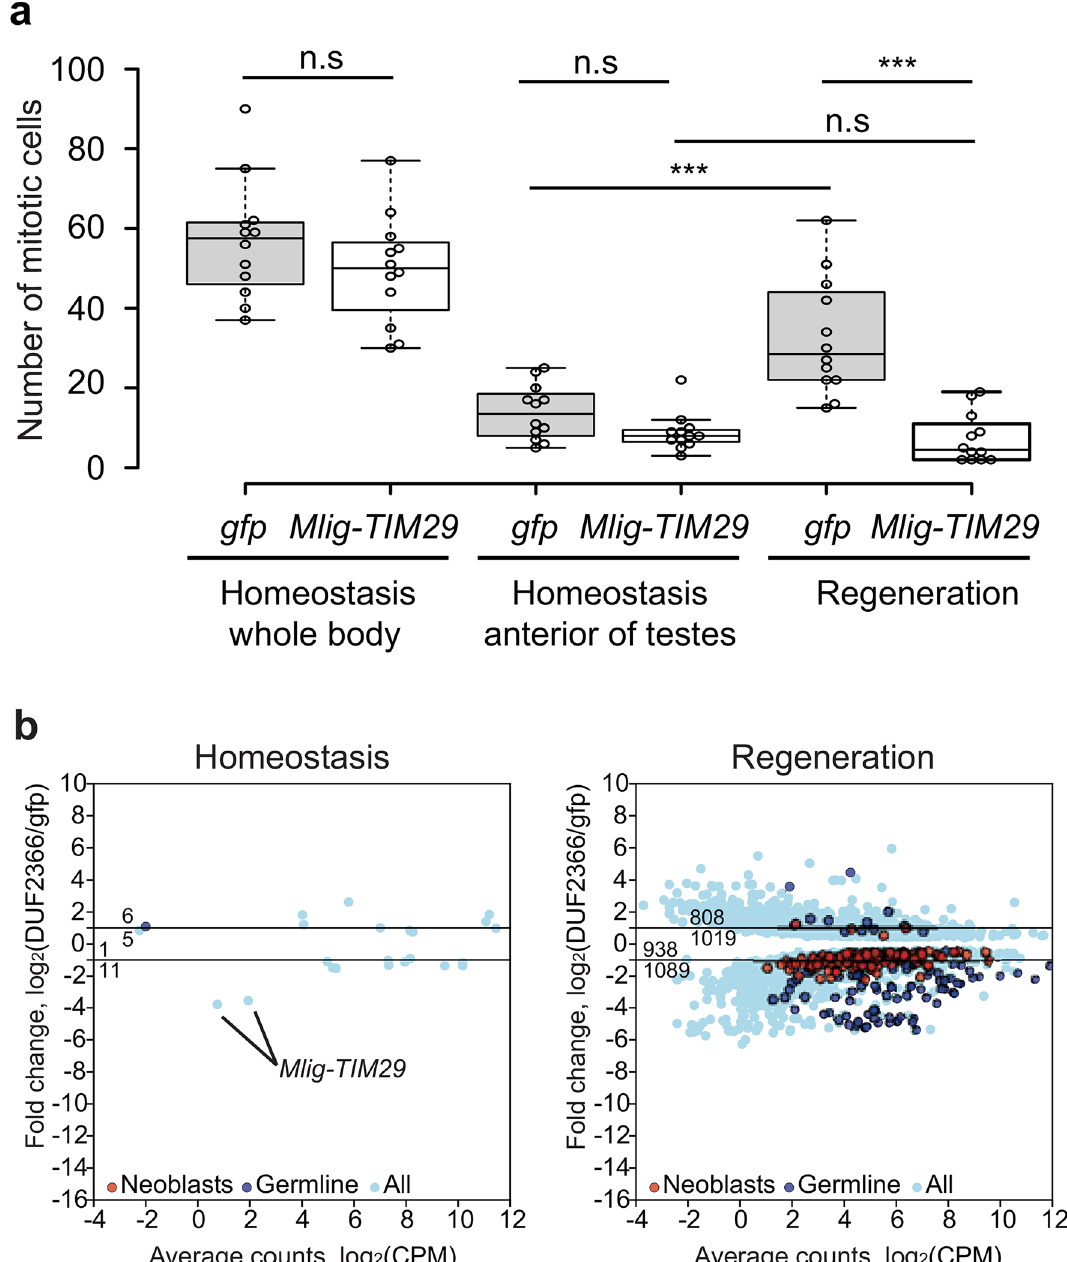
Figure 4. The effect of Mlig-TIM29 (RNAi) on the number of mitotic cells and gene expression. ( a ) Mlig-TIM29 (RNAi) causes a significant decrease in the number of mitotic cells in regenerating worms (Regeneration), but not in uncut worms (Homeostasis whole body). To allow comparison between cut and uncut worms, the number of mitotic cells was quantified in the head and pharynx region of uncut worms (Homeostasis anterior of testes) which corresponds with the fragment left after amputating the body. In control gfp (RNAi) worms, regeneration causes a significant increase in the number of mitotic cells. This is not observed in Mlig-TIM29 (RNAi) worms. n.s.: p > 0.05, *** p < 0.001 (ANOVA and post-hoc Tukey test). ( b ) Genes differentially expressed between gfp (RNAi) and Mlig-TIM29 (RNAi) worms during homeostasis (uncut worms) and regeneration (cut